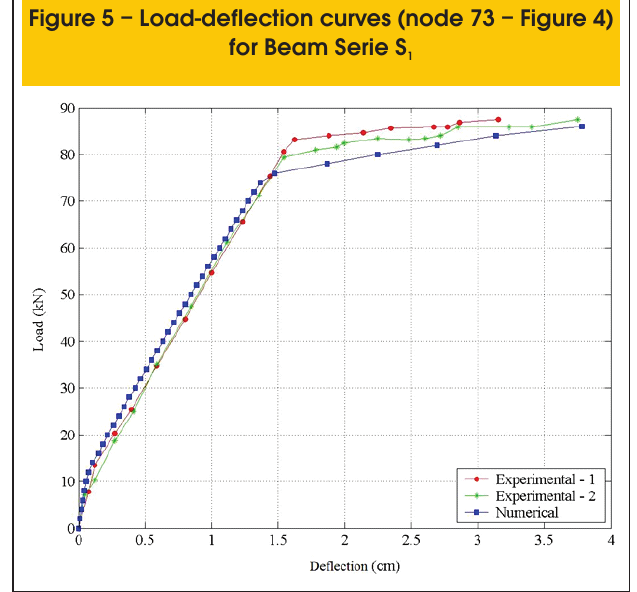
Figure 5 – Load-deflection curves (node 73 – Figure 4) for Beam Serie S 1